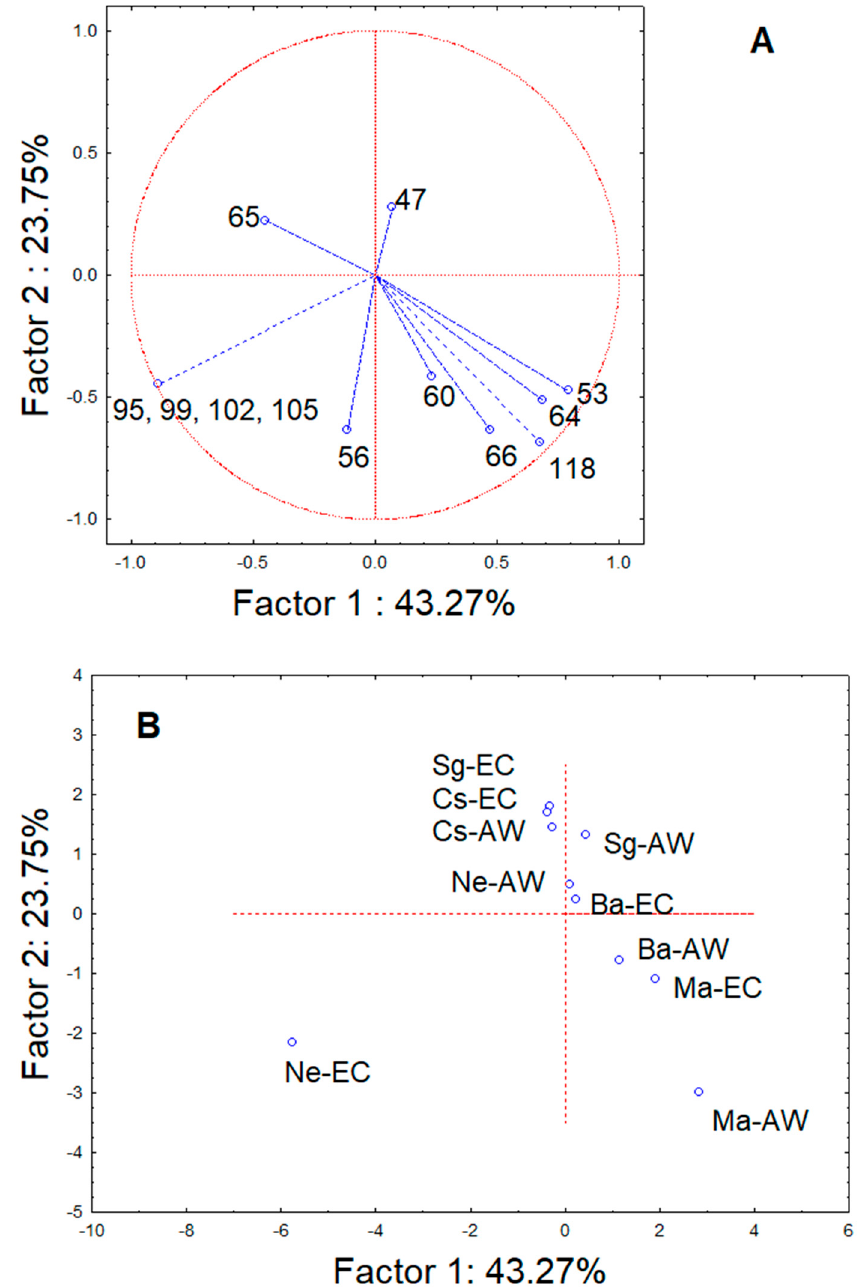
Figure 9. Principal component analysis run on some selected alcohols. ( A ) Variable projection; ( B ) case projection. Sg, Sangiovese; Ma, Magliocco; Ba, Barbera; Cs, Cabernet-Sauvignon; Ne, Negroamaro. EC, strain EC1118; AW, strain AWRI796. 47: 2-methylbutane-1,3-diol; 53: 3-methylbutan-